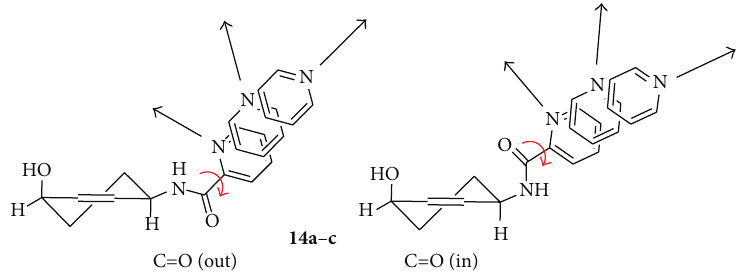
Figure 1: Orientations of the pyridine rings in conformers 14a–c . Red arrows indicate rotation around the C=O-Het bond for all the possible conformers of the pyridine rings. Table 1: Primary antiviral activities of compounds 13a–d and 14a–d against influenza A H1N1 virus. Entry Compounds EC